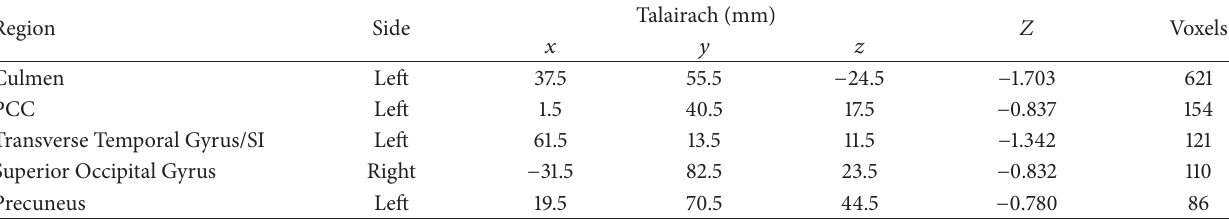
Table 3: Intergroup analysis of areas when making lip pursing movements.